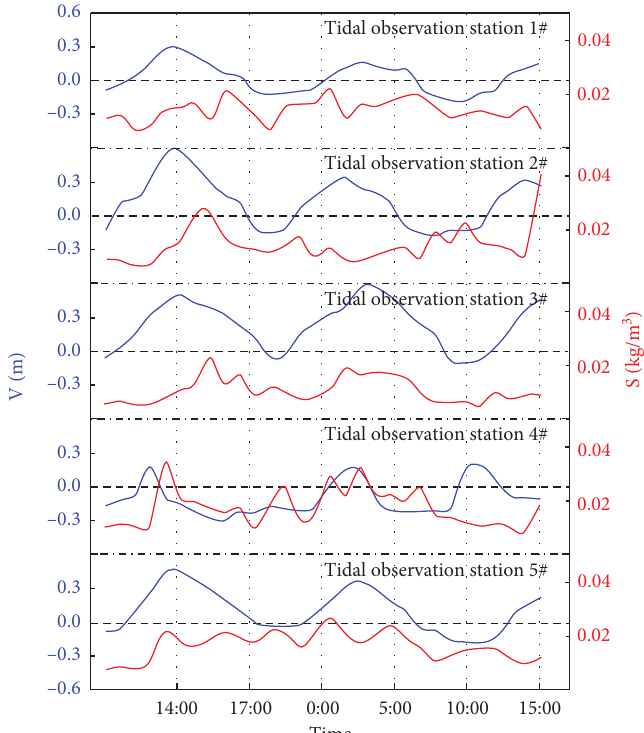
Figure 5: The vertical resultant velocity and sediment concentration of the neap tide during Sep. 22 ∼ 23, 2015. The blue curves are the vertical resultant velocities at each tidal observation station corresponding to the left blue axis. The red curves are the sediment con- centration measured at each tidal observation station corresponding to the right red